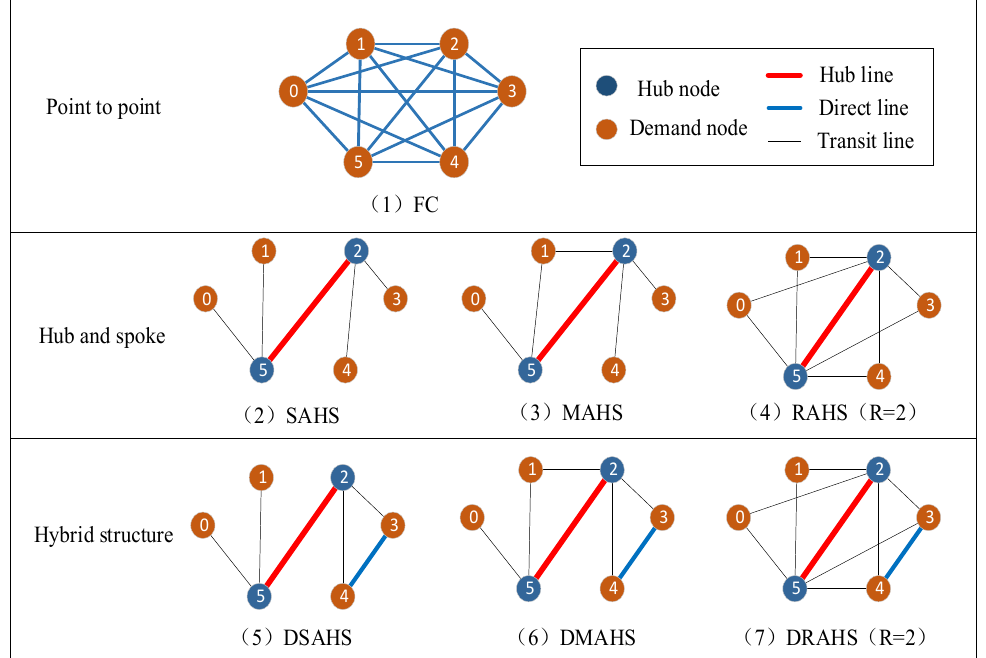
Fig. 1. Topologies commonly used in transportation network